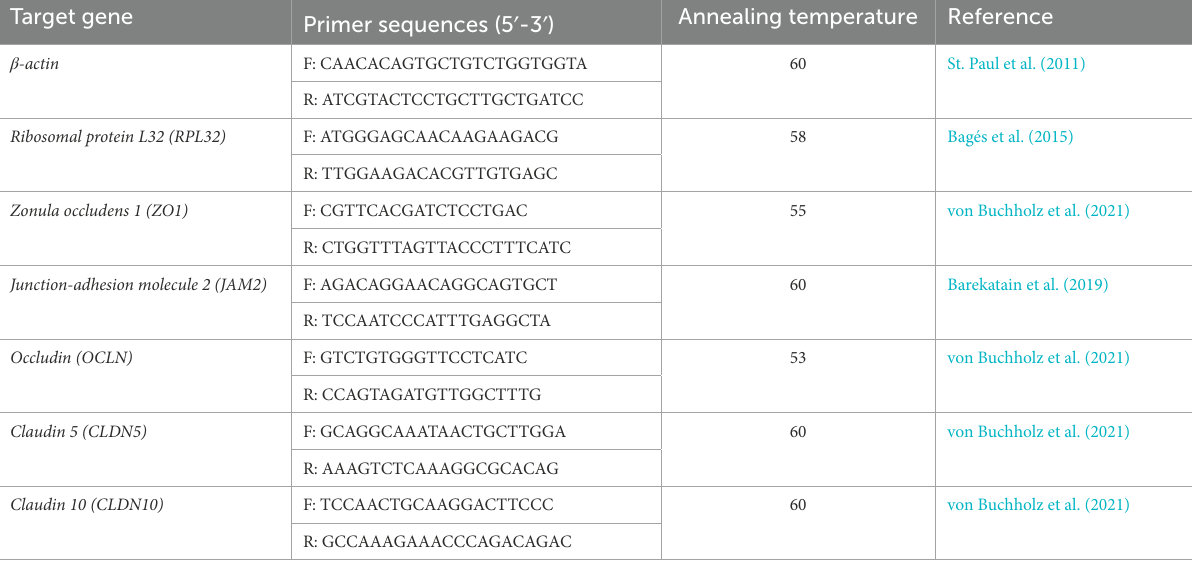
TABLE 2 Primer sequences used for RT-qPCR. Target